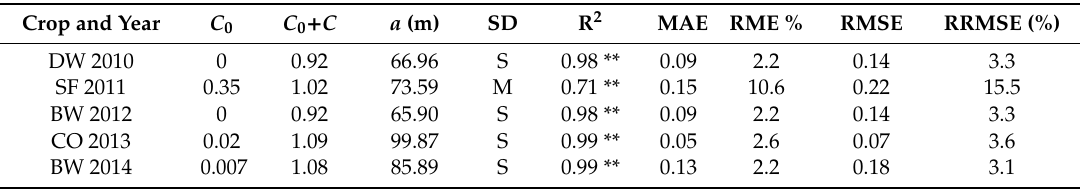
Table 6. Parameters of the spherical model used to fit the experimental semivariograms of crop yields and model performance in the five